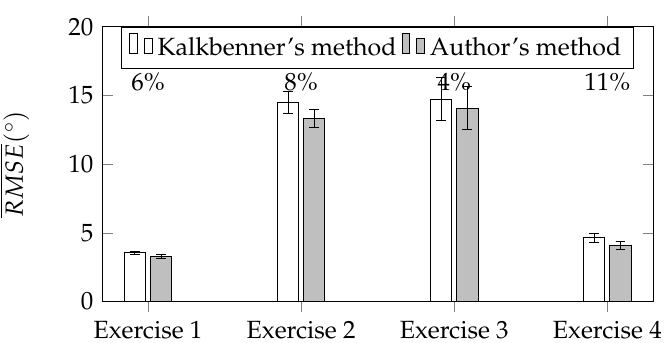
Figure 18. Average root square mean error RMSE of the elbow flexion angle β